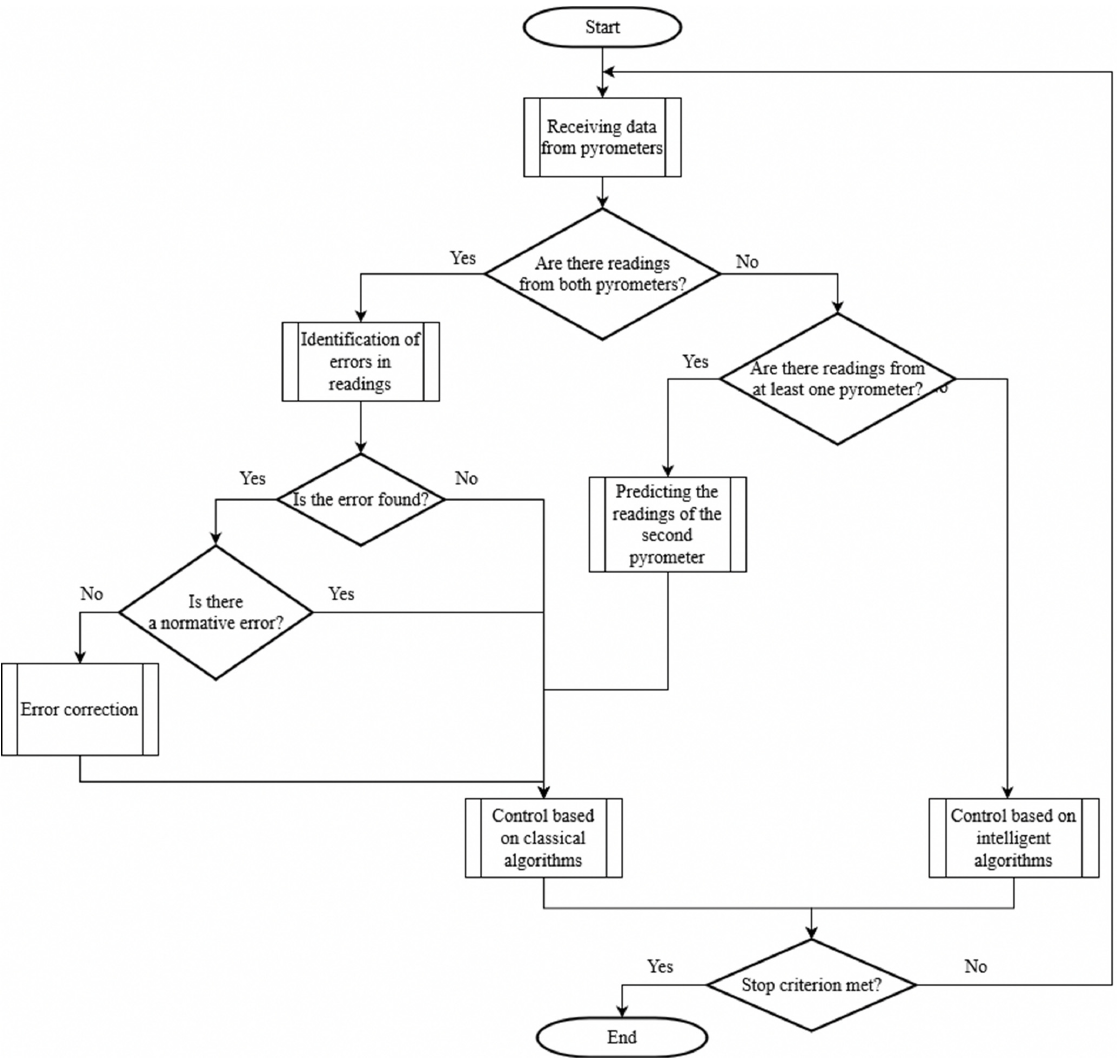
Figure 5. Algorithm for the intelligent control of the induction brazing process.